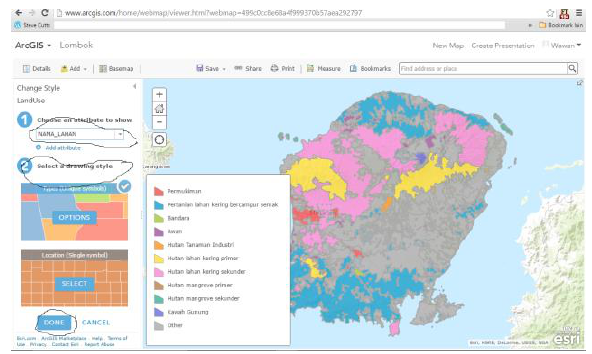
Figure 11: Example of an Enterprise GIS system for an organization